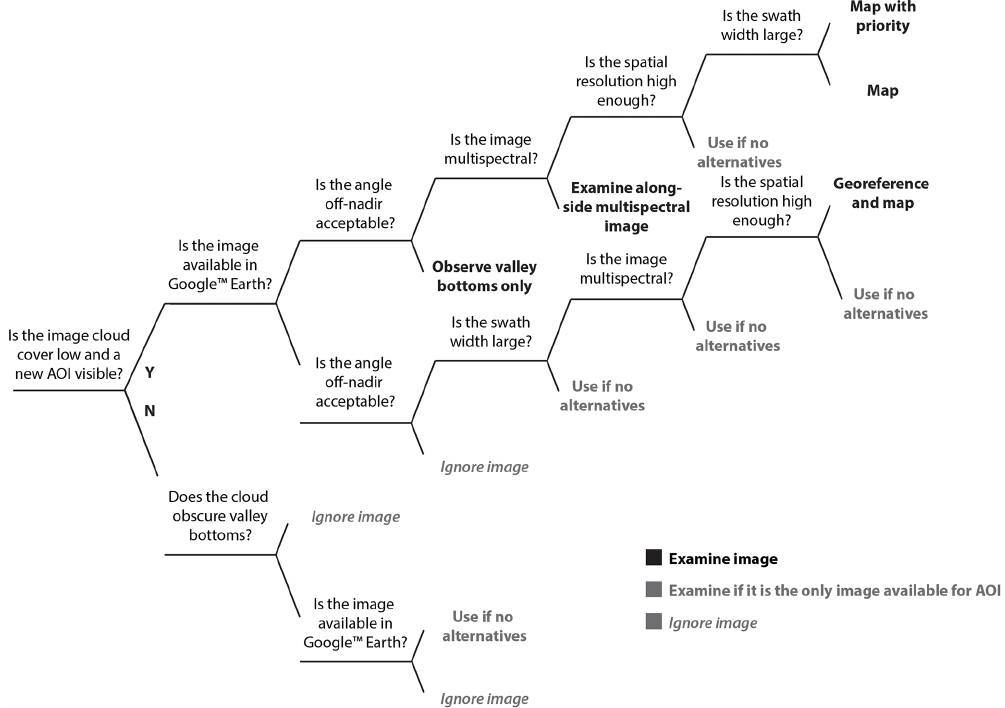
Figure 1. Decision tree for prioritizing imagery used by Durham University for landslide mapping after the 2015 Gorkha earthquake. The relative importance of criteria decreases from left to right. Datasets were prioritized if they were efficient to pre-process and provided high-resolution data optimal for mapping. Imagery with large swath widths and acceptable off-nadir angles may be difficult to acquire in mountainous terrain. These criteria were therefore prioritized to reduce the time spent georeferencing and the number of images required. Given the submeter resolution of VHR imagery and the ability to pan-sharpen multispectral imagery, most image resolutions are now sufficient to map landslides with the potential to cause significant damage. Spectral resolution was therefore considered as a more useful criterion for distinguishing landslides of this type than spatial resolution. This decision tree may also be applied to image selection for automated landslide